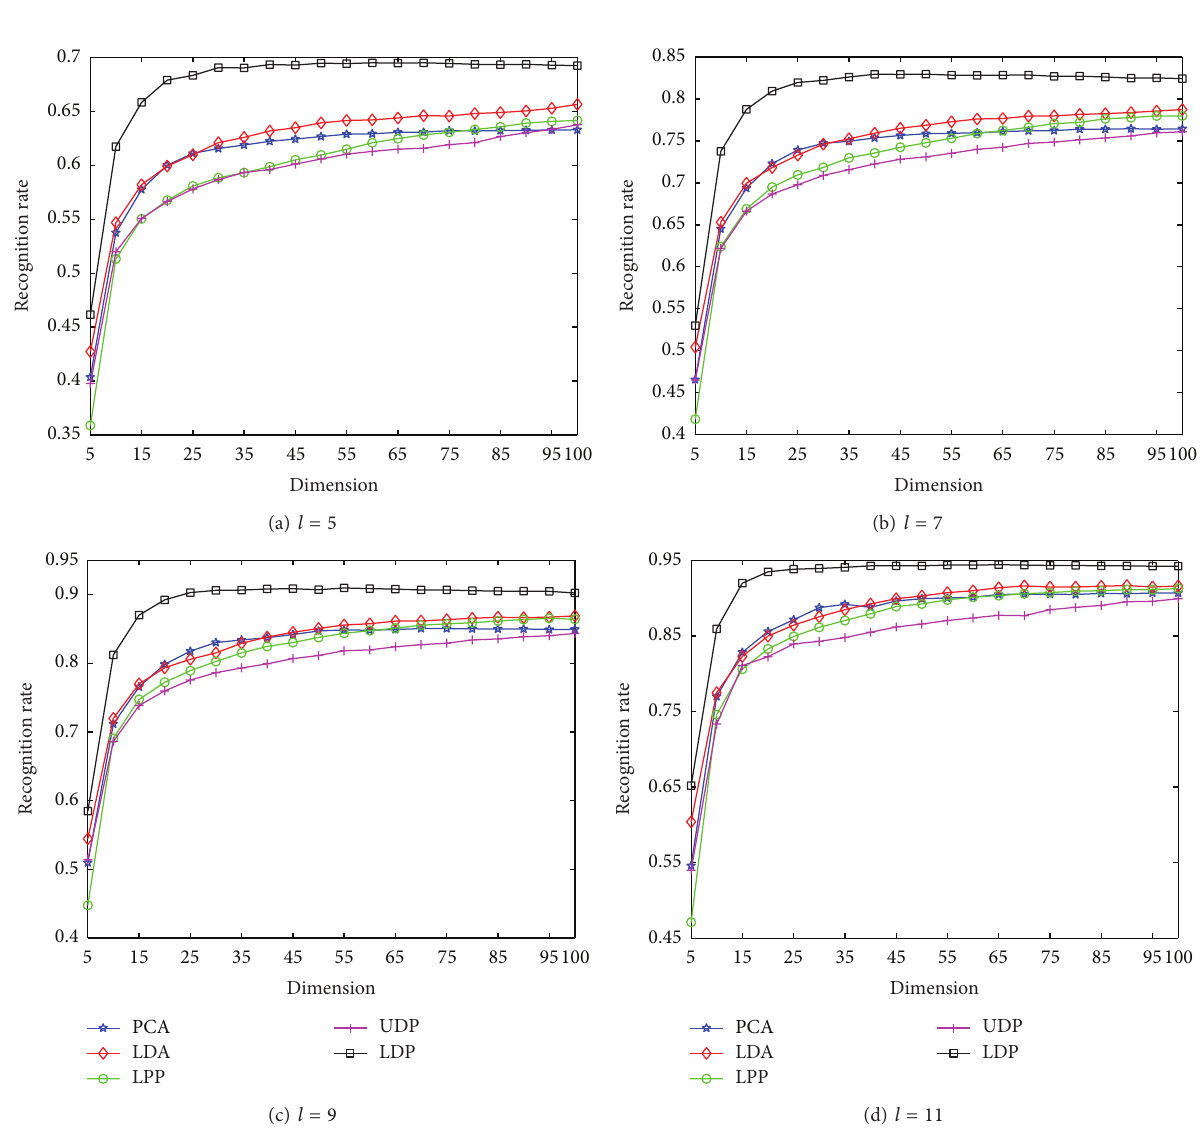
Figure 6: The average recognition rates versus dimension on FKP.